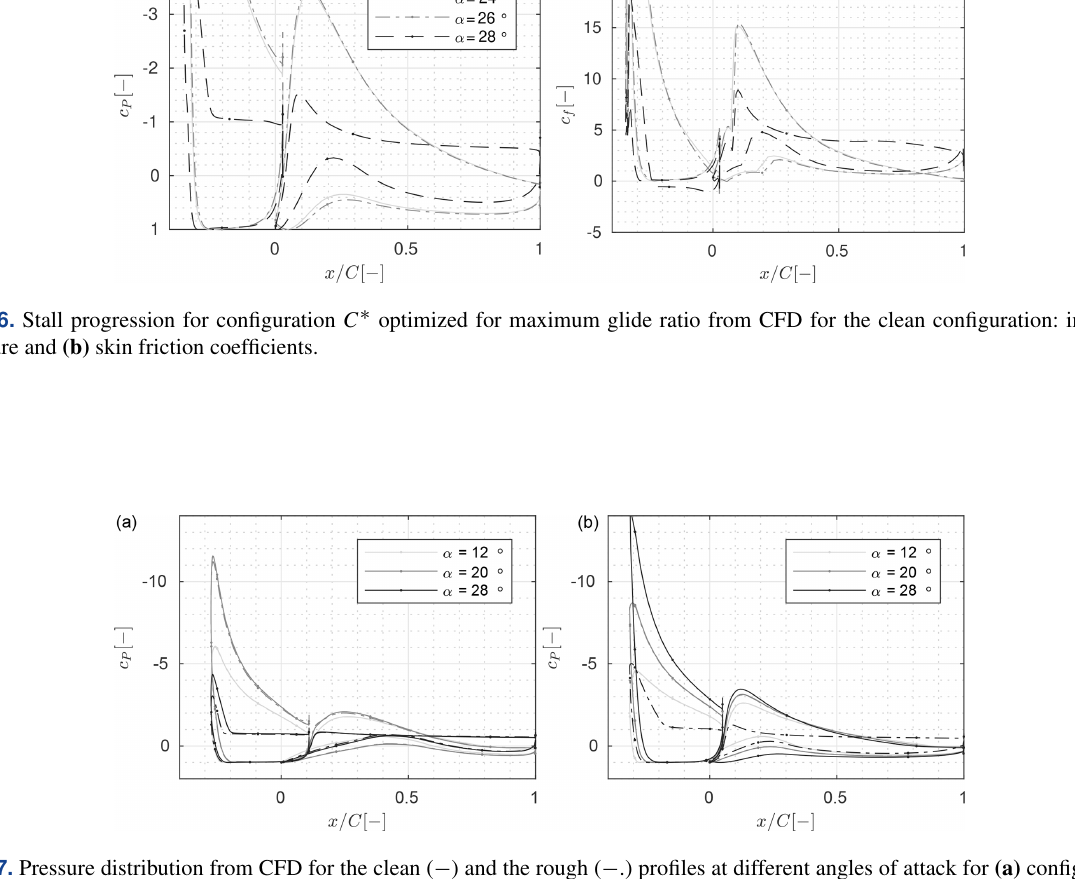
Figure 17. Pressure distribution from CFD for the clean ( − ) and the rough ( − . ) profiles at different angles of attack for (a) configuration B and (b) configuration B ∗